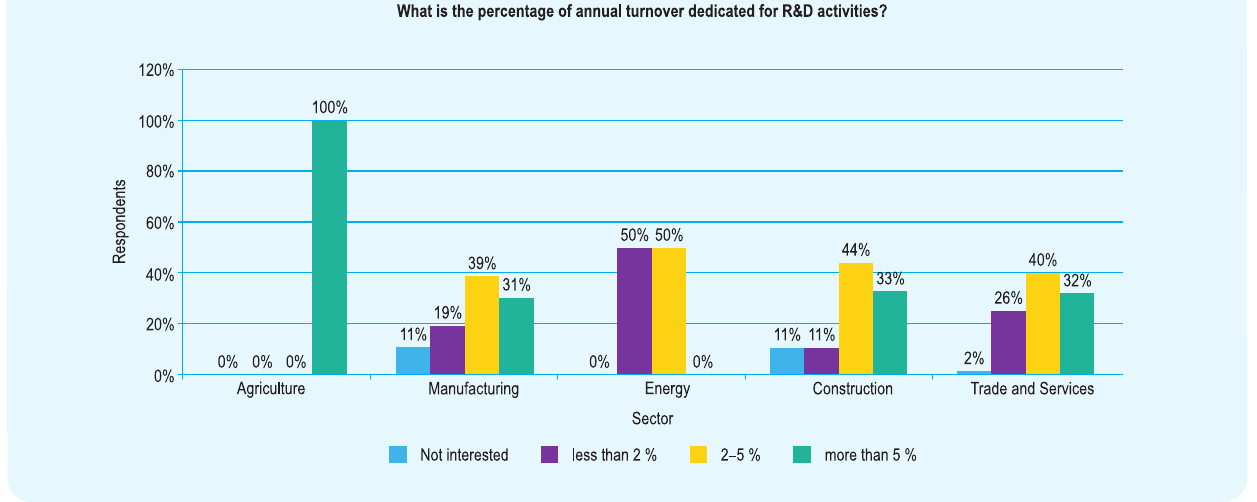
Fig 2. Percentage of dedicated funds for Research and Development activities for businesses with